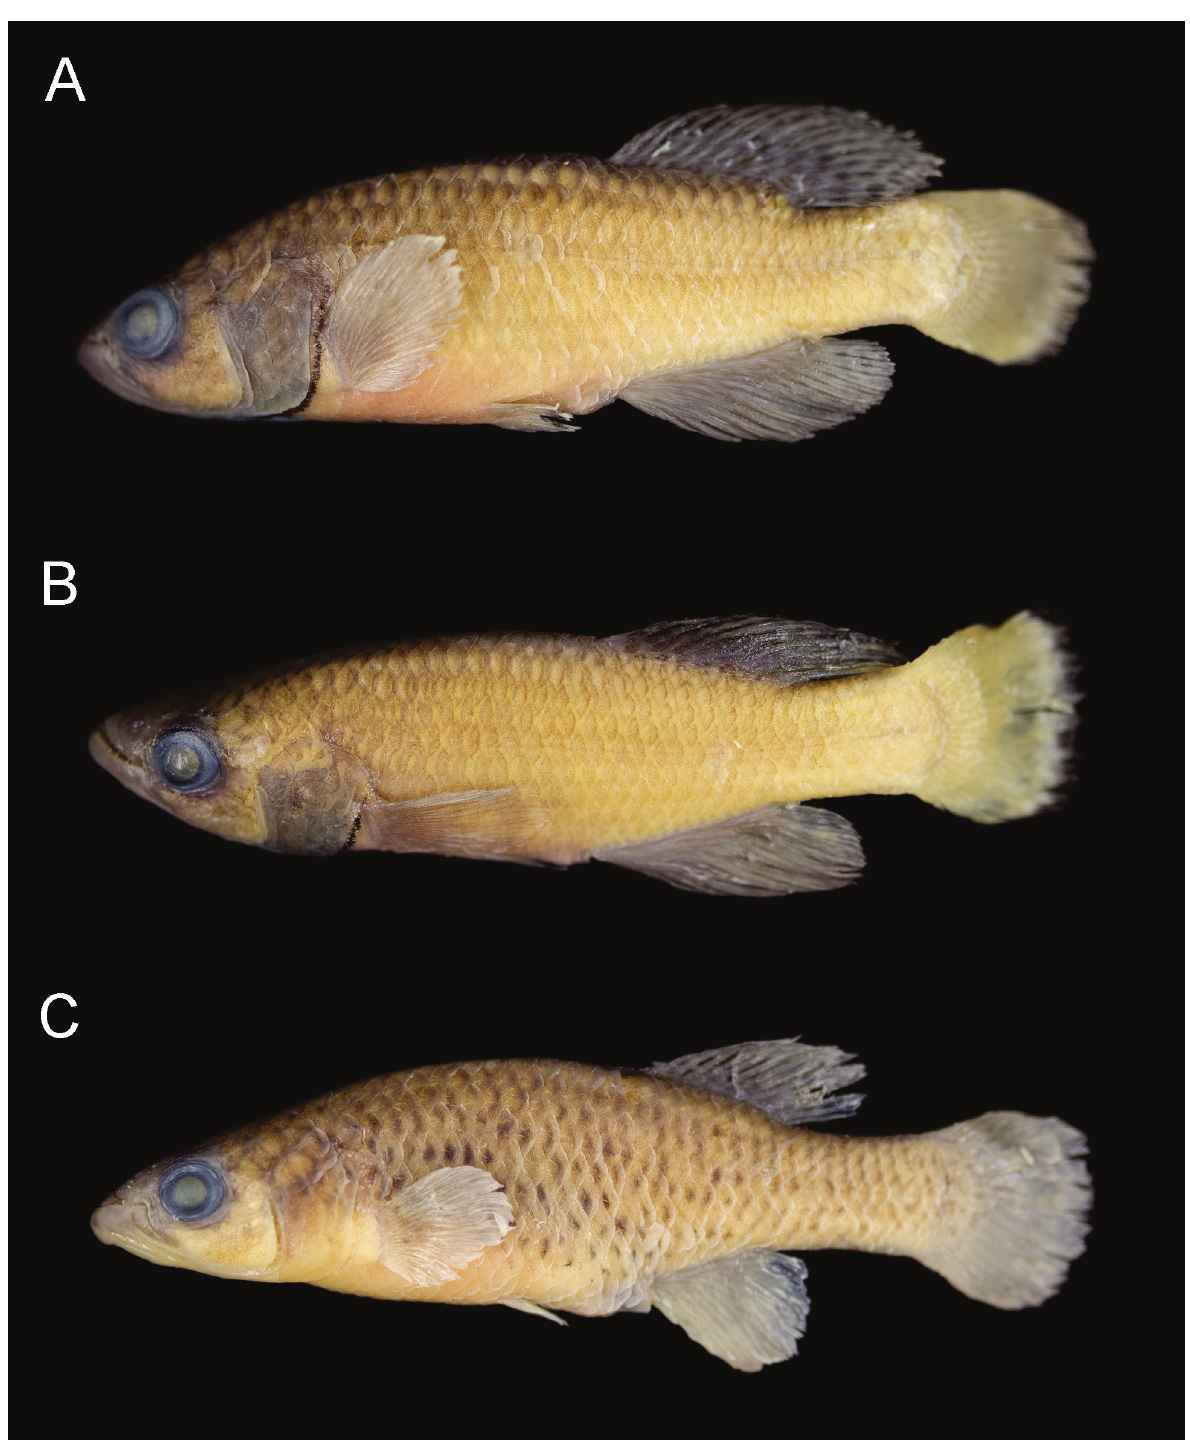
Figure 3. Nothobranchius insularis sp. n.: A. MRAC A7-02-P-33, holotype, male, 52.9 mm SL; Tanzania: 3 km S of Kirongwe, Mafia Island; B. MRAC A7-02-P-38-44, paratype, male, 48.3 mm SL; Tanzania: 0.5 km S of Kirongwe, Mafia Island; C. MRAC A7-02-P-38-44, paratype, female, 49.8 mm SL; Tanzania: 0.5 km S of Kirongwe, Mafia Island.